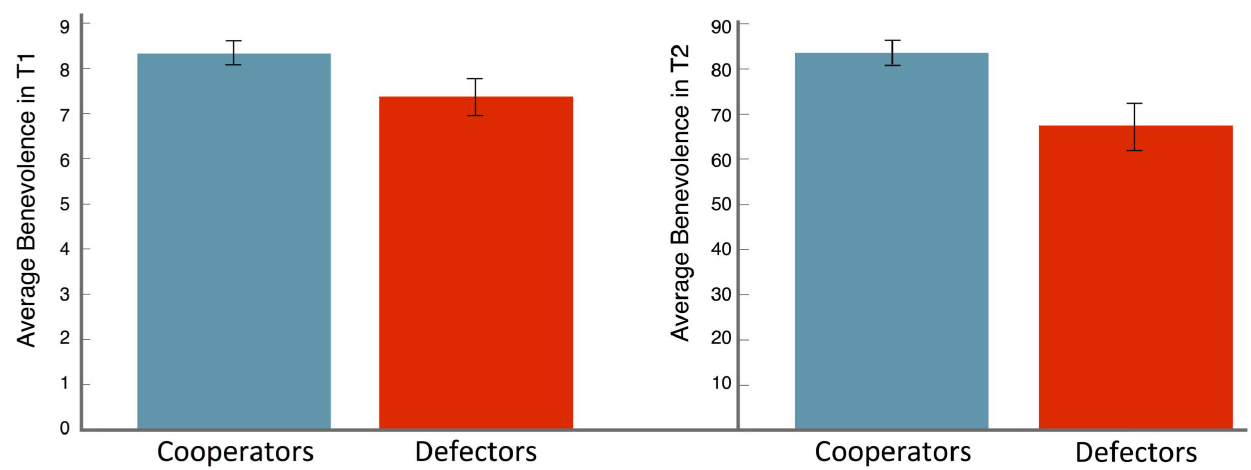
Figure 2. Average level of benevolence of cooperators and defectors in T1 and T2, with error bars representing the standard error of the mean. In both treatments benevolence is positively correlated with cooperation.